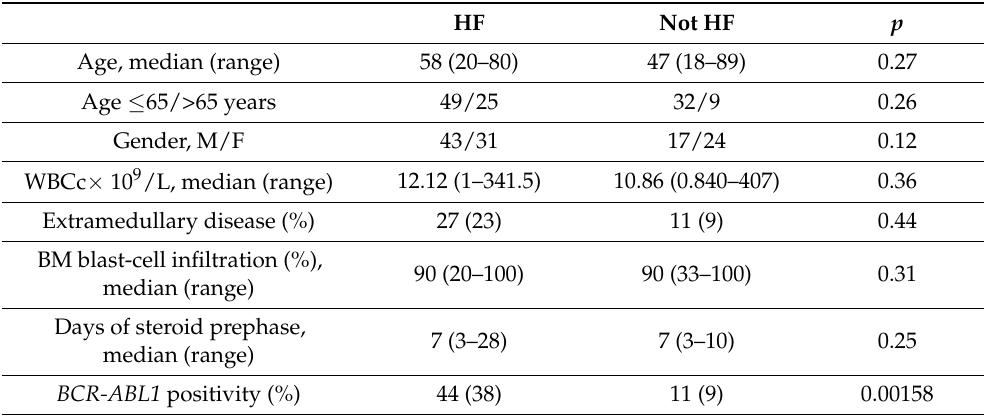
Table 3. Univariate